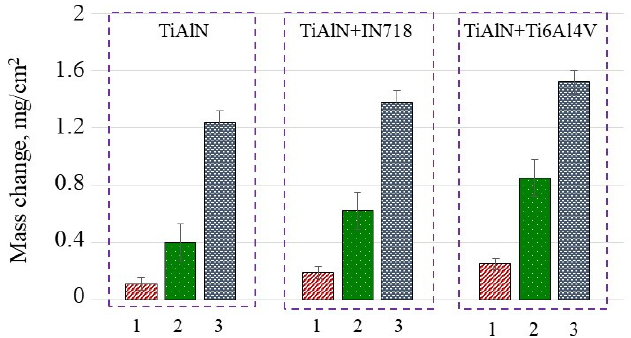
Figure 2. The mass gain of oxidized samples after annealing performed at 900 ◦ C for 2.5 min (1); 10 min (2) and 30 min (3). For the diffusion couples 3 (annealing time of 30 min) the appropriate values of mass change are equal to 1.36 ± 0.06 and 1.50 ± 0.06.